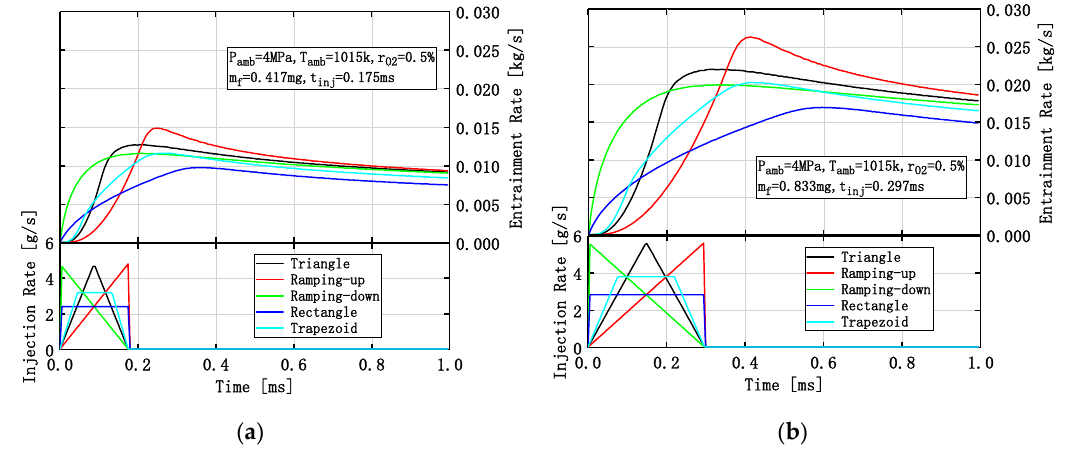
Figure 6. Entrainment rate under ( a ) the injection quantity of 0.417 mg and ( b ) injection quantity of 0.833 mg.